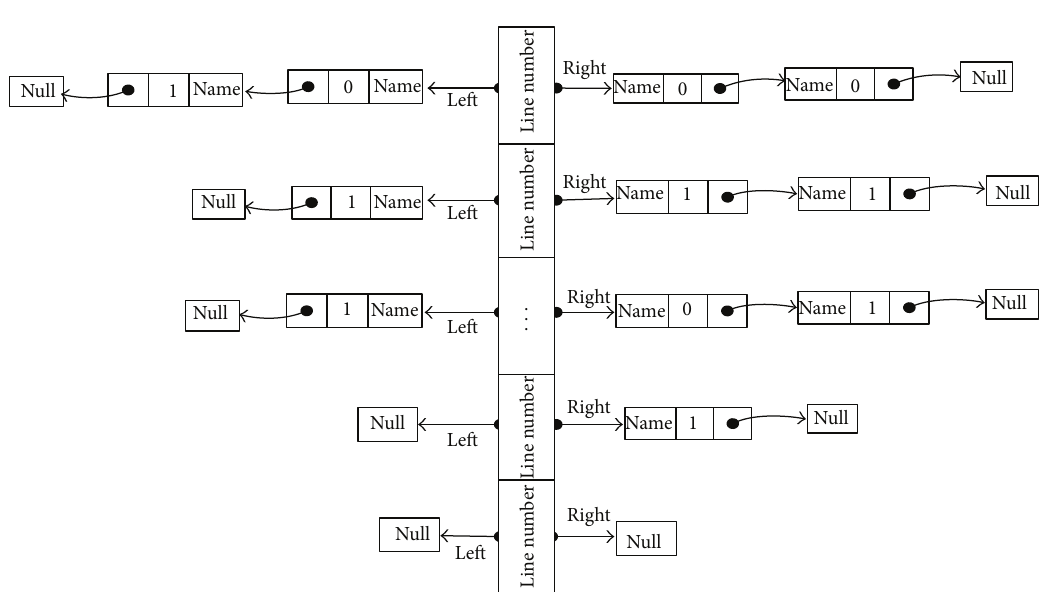
Figure 2: Data-dependent storage